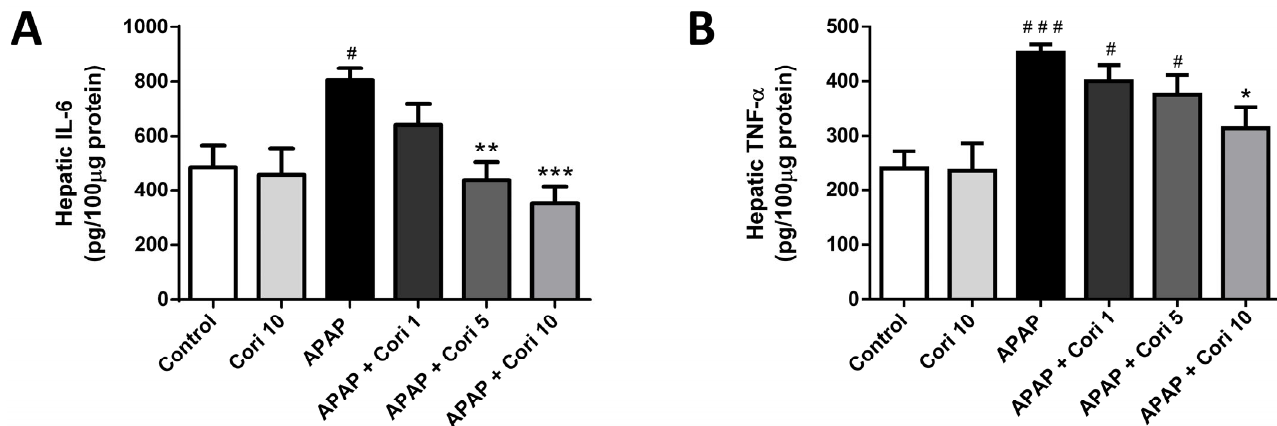
Figure 4. The effects of corilagin on IL-6 ( A ) and TNF- α ( B ) concentrations in acetaminophen-induced hepatic injury. Animals were intraperitoneally injected with APAP (300 mg/kg) or equal volume of saline (control), and administrated with various concentrations of corilagin (0, 1, 5, or 10 g/kg) after 30 min. # p < 0.05, ### p < 0.005 vs. control group; * p < 0.05, ** p < 0.01, *** p < 0.005 vs. APAP group.